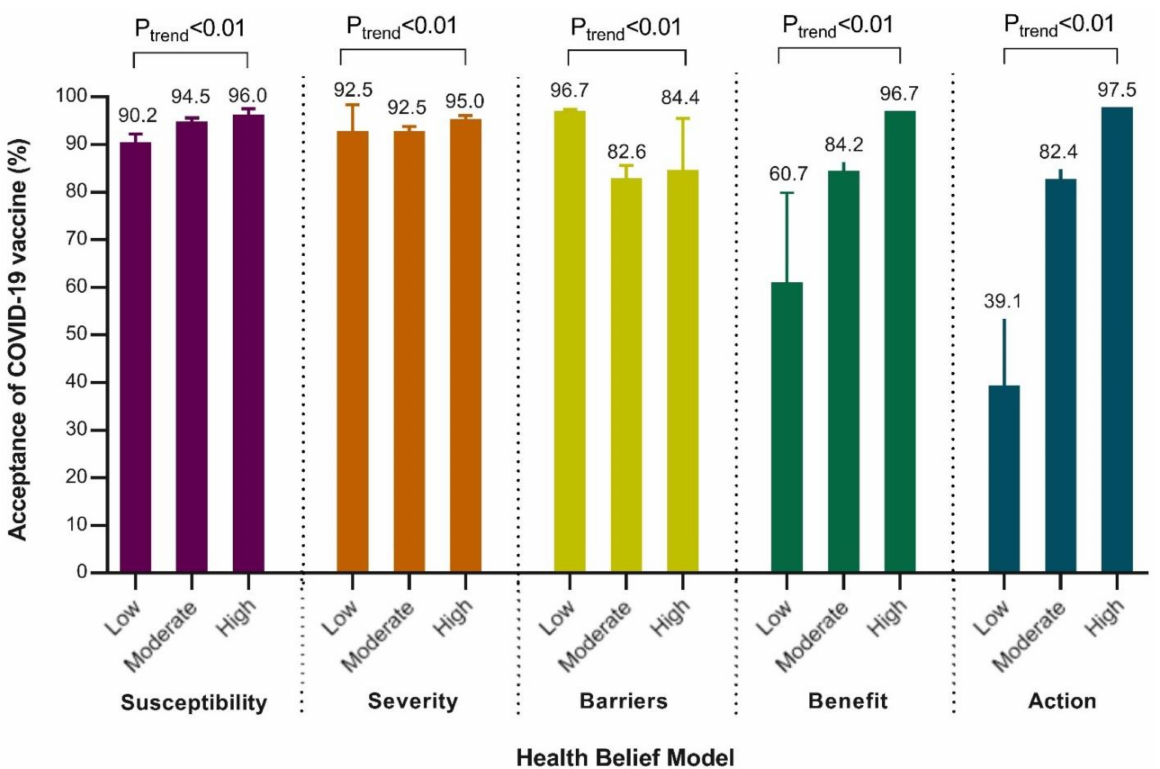
Figure 1. The acceptance of a third dose of COVID-19 vaccine by five dimensions of the health beliefs model (n =